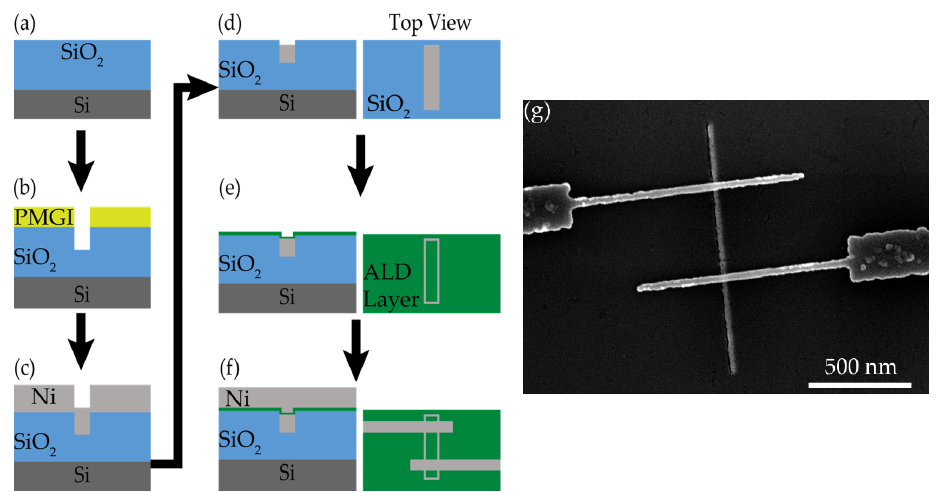
Figure 2. Process steps in fabricating the “half ‐ damascene” cross ‐ tie SET: ( a ) Si substrate (dark grey) is oxidized (SiO 2 in blue); ( b ) a trench for the island is etched through an EBL defined polymethylglutarimide (PMGI) mask (yellow); ( c ) metal (light grey, e.g. Ni) is deposited; ( d ) the chemical mechanical polishing (CMP) step is performed and metal island is formed; ( e ) ALD dielectric (green) is deposited; ( f ) metal source and drain electrodes (light grey) are deposited; and ( g ) micrograph of half ‐ damascene SET (gate not shown). The nearly vertical line is the inlaid island and the slightly wider, nearly horizontal lines are the source and drain.